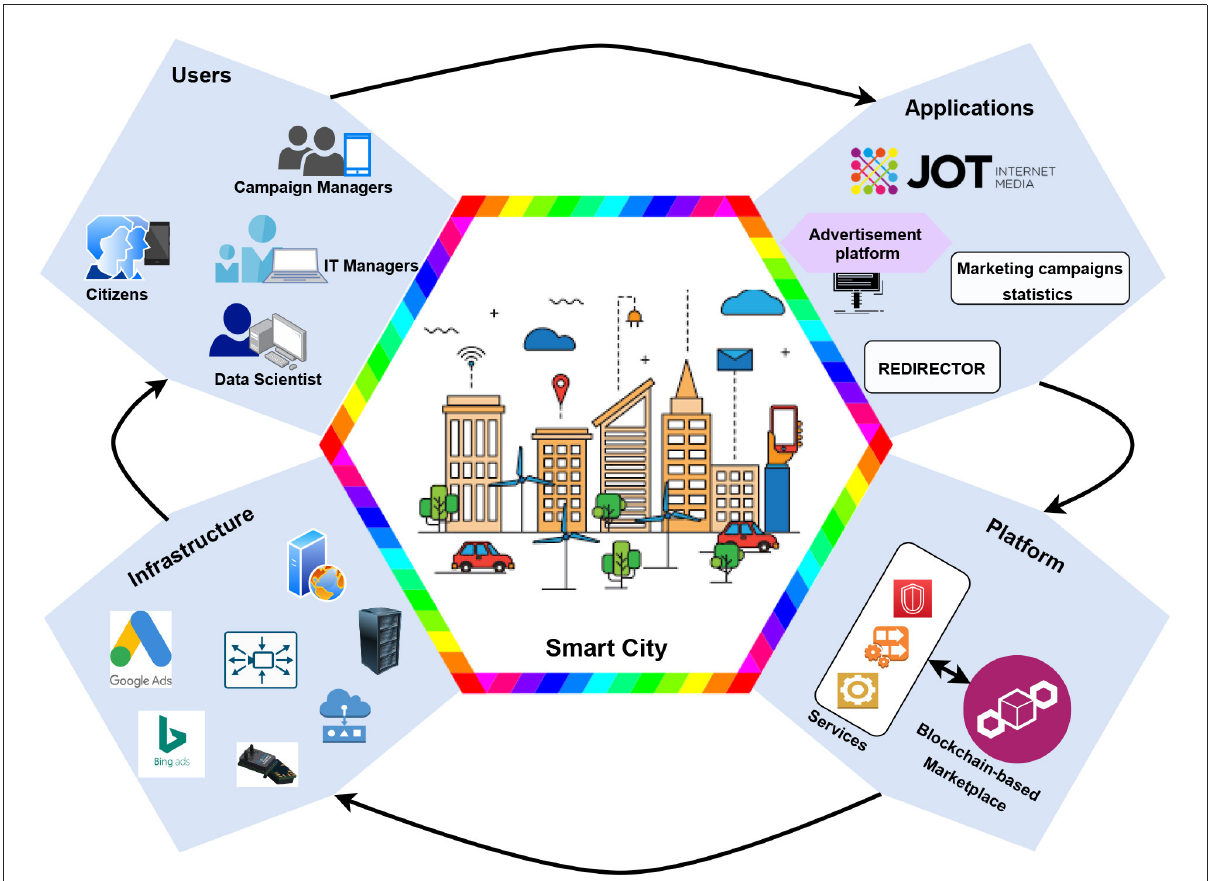
FIGURE2 Life-cycle of analytical pipelines of marketing campaigns